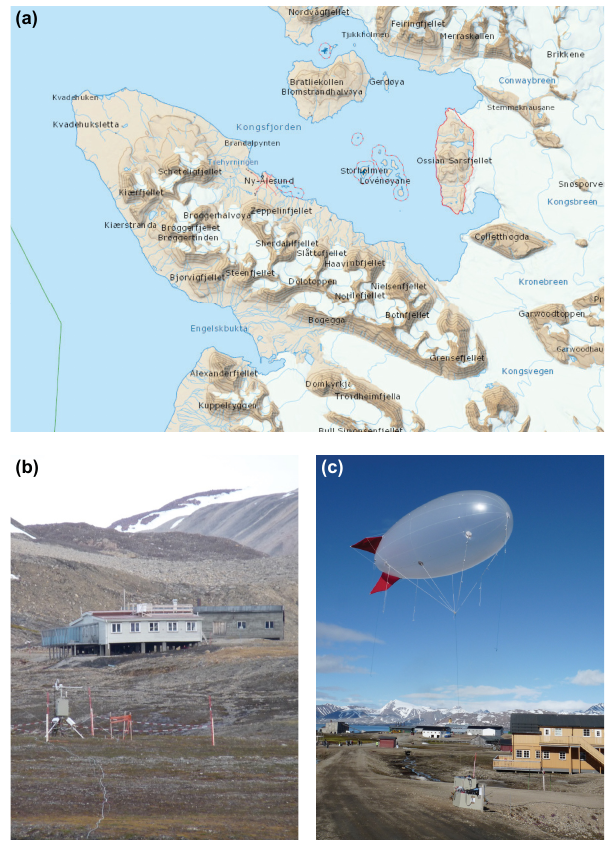
Figure 1. (a) Ny-Ålesund, the Kongsfjord and the surrounding orography; (b) Gruvebadet sampling site; (c) the tethered balloon in